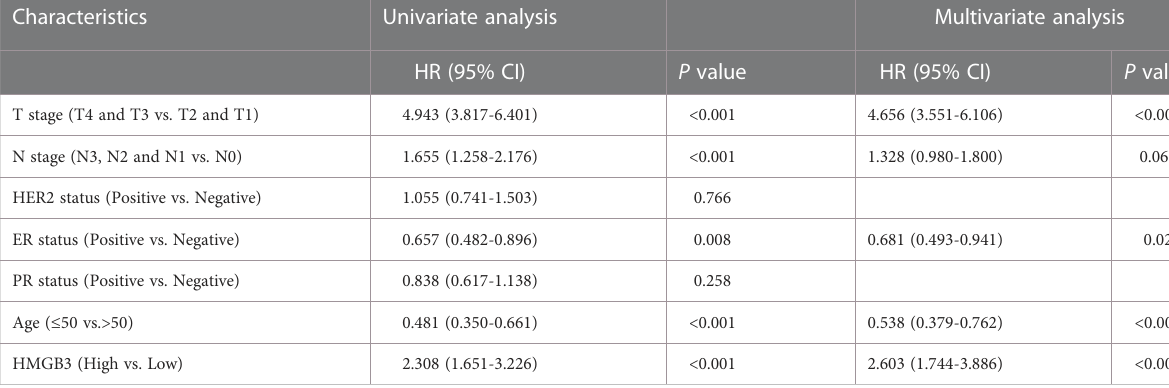
TABLE 3 Cox regression analysis of overall survival in patients with metastatic breast